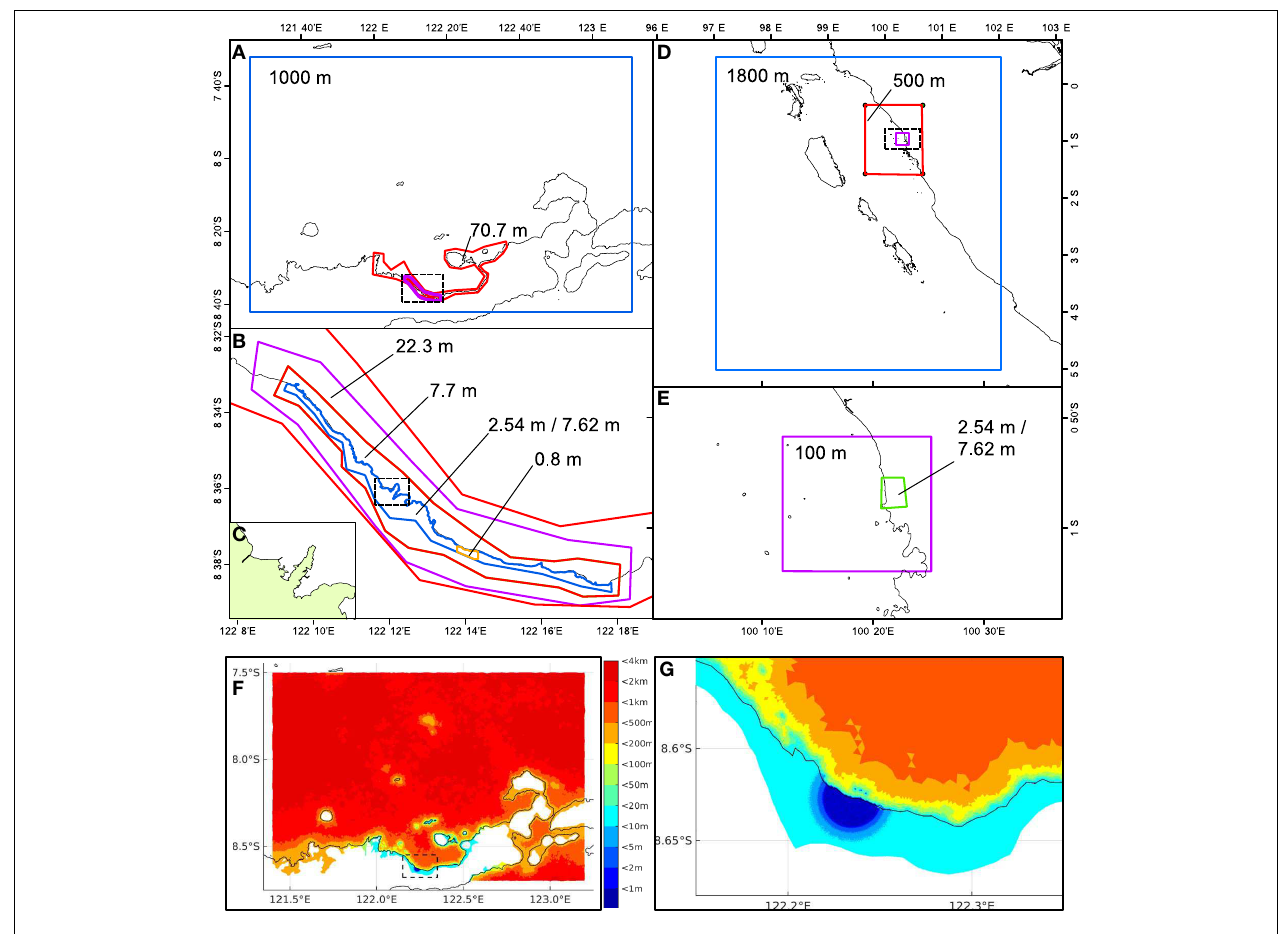
dashed black line showing the high resolution area shown in (E); (E) the coastline near Padang. The mesh resolution (m) in each polygon is indicated by the numbers in black. The blue rectangles in (A, D) outline the model boundaries for Maumere and Padang, respectively. Internal mesh resolution for TsunAWI model for Maumere is shown in (F) with dashed black line showing the high resolution area shown in (G)